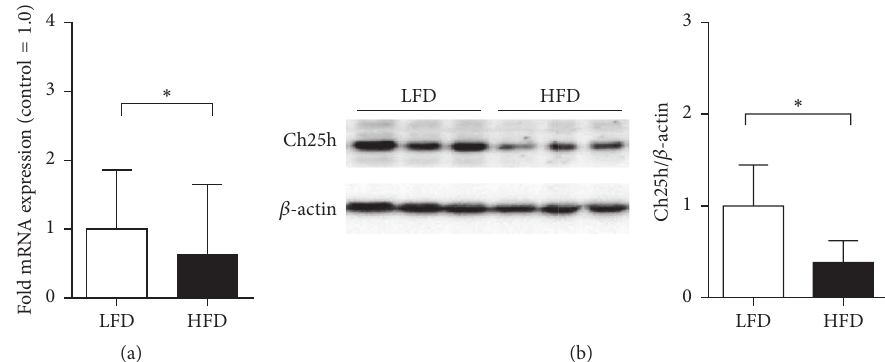
Figure 1: HFD treatment on mice resulted in decreased hepatic Ch25h protein levels. (a) Ch25h mRNA levels in isolated livers obtained from mice on HFD and control LFD. mRNA levels of hepatic Ch25h levels in LFD mice were xxx-fold higher comparing to mice on HFD. ∗ 𝑝 = 0.036 , 𝑛 = 10 per group. (b) Immunoblot analysis of Ch25h protein in isolated livers obtained from mice on HFD and control LFD. Mice on HFD showed a clear reduction in liver Ch25h protein levels comparing to the littermate controls. 𝛽 -Actin was used as a loading control. ∗ 𝑝 = 0.046 , 𝑛 = 3 per group.